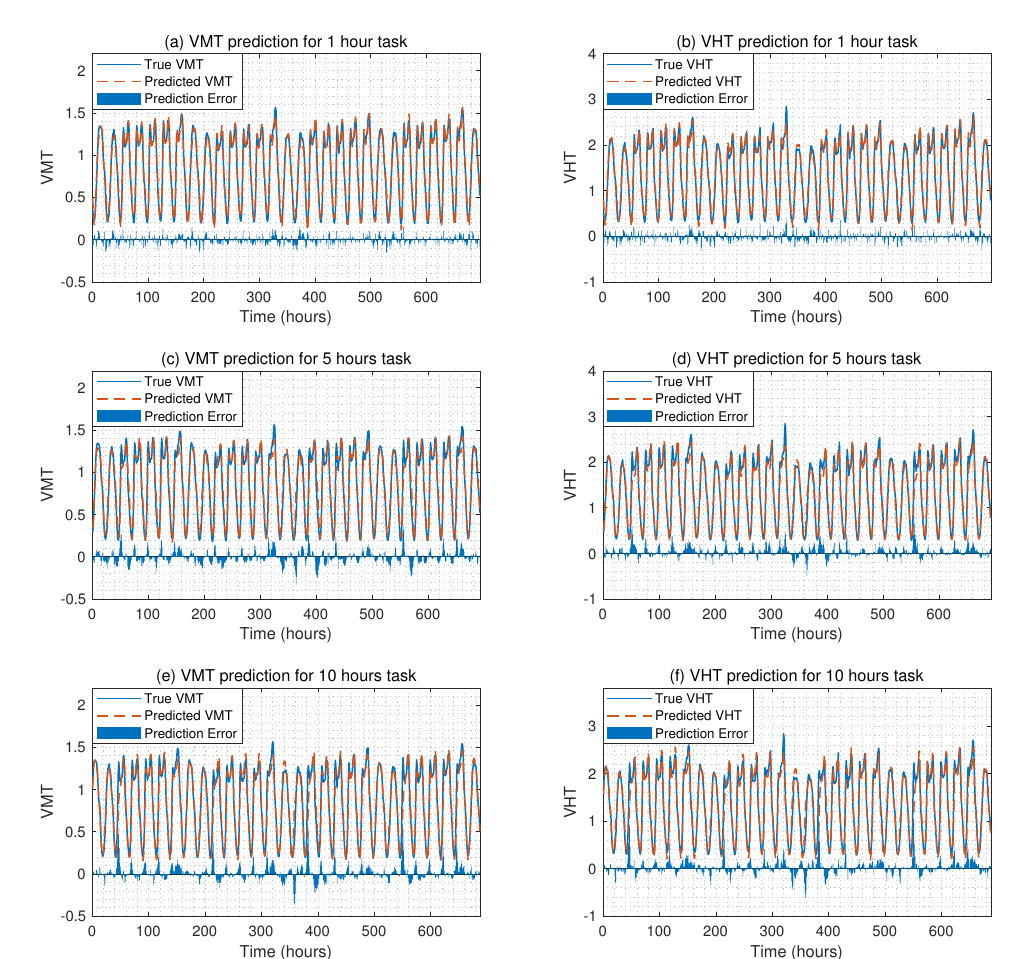
Figure 6. The VMT and VHT prediction results for three different tasks under the second case, where ( a , c , e ) show the VMT predictions for three tasks; and ( b , d , f ) show the VHT predictions for three